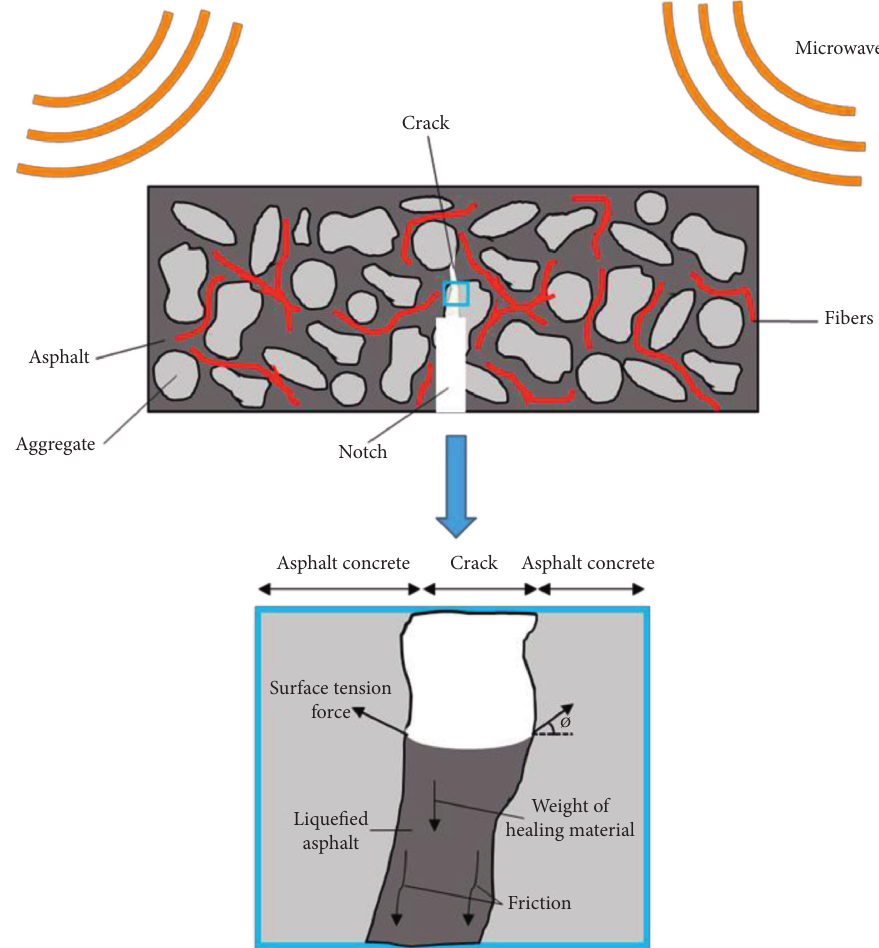
Figure 7: Schematic demonstration of microwave healing mechanism